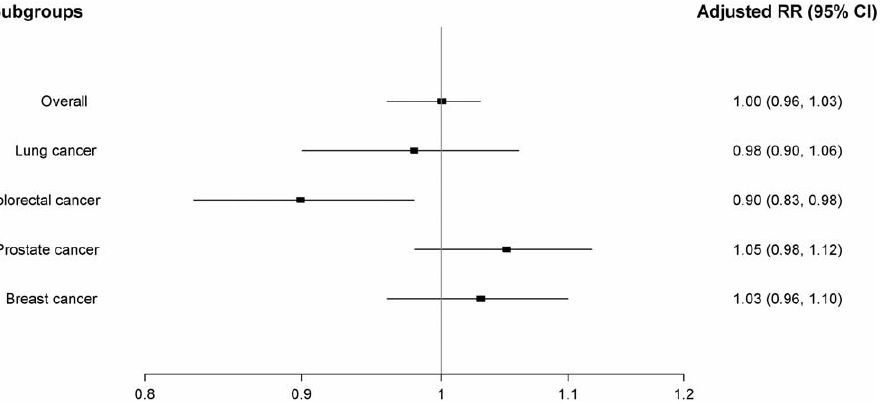
Figure 2. Adjusted rate ratios of specific cancers associated with use of angiotensin receptor blockers relative to the use of diuretics or beta-blockers.